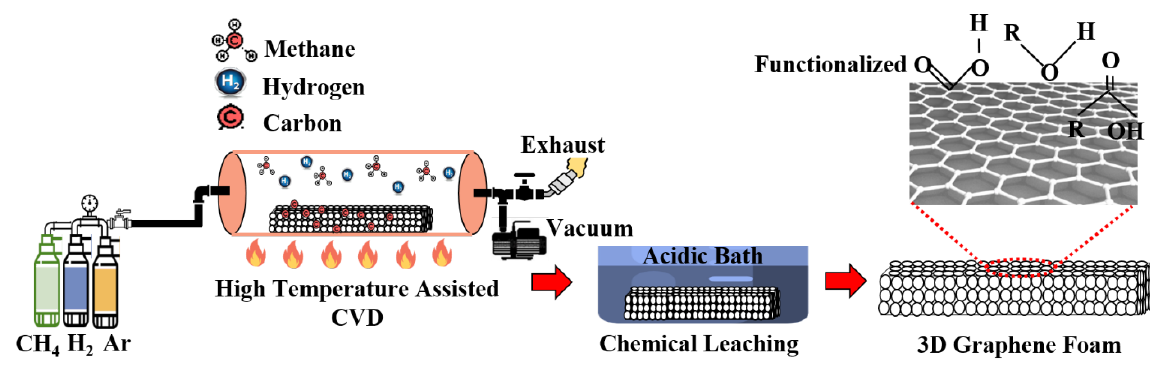
Figure 5. Schematic showing the production of 3D GrF by CVD technique [29 – 31] .